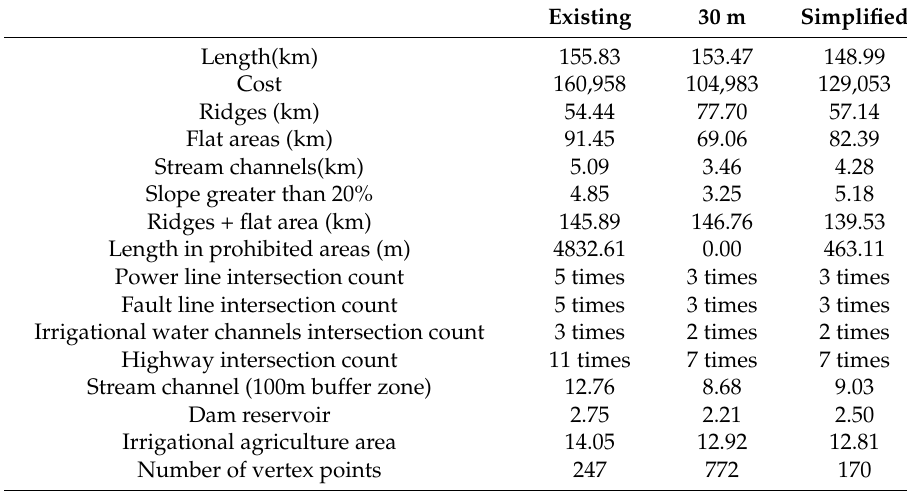
Figure 14. Simplification process on the suggested route. Table 8. The values obtained from the simplification process and comparison.